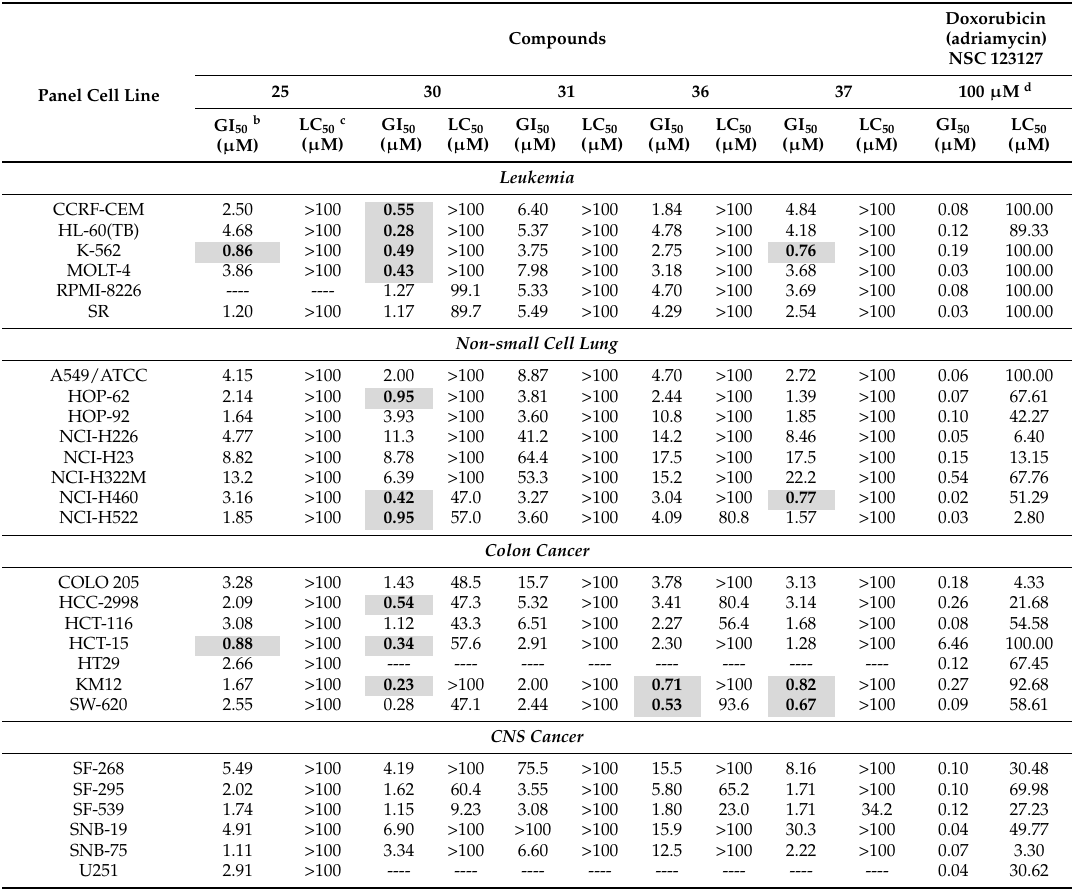
Table 2. In vitro cytotoxic activities of compounds 25 , 30 , 31 , 36 , and 37 , expressed as growth inhibition and lethal concentration of cancer cell lines and compared with the standard drug adriamycin a .